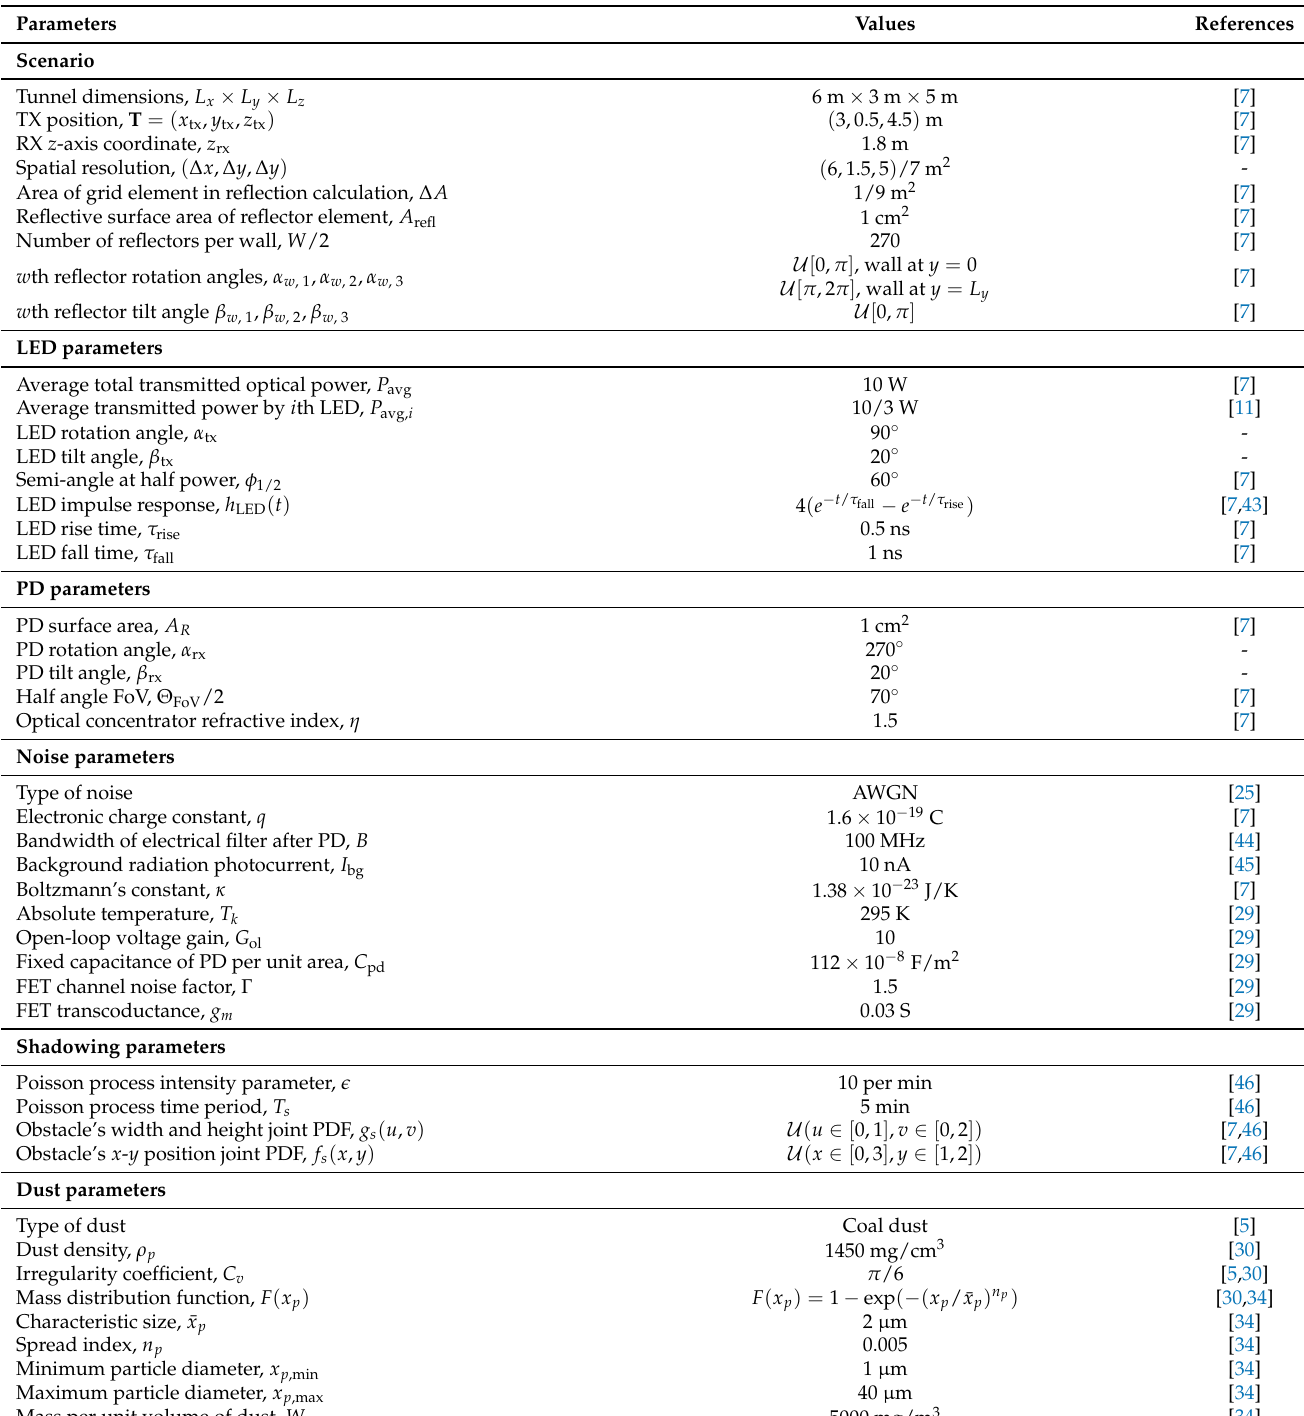
dimensions of the scenario and the channel parameters used in this work are defined in Table 2. All the spectral parameters used in the simulation are presented in Figure 4. The SPDs for each LED, Φ 1 ( λ ) , Φ 2 ( λ ) , Φ 3 ( λ ) , are collected from [42] and were selected because they have already been used in an experimental CSK setup in [10,24]. Their [ 620, 645 ] (nm), λ [ 520, 540 ] (nm), dominant wavelengths are in the ranges λ R G ∈ ∈ [ 460, 485 ] (nm) for the red, green, and blue LEDs, respectively. and λ B ∈ Table 2. UM-VLC system